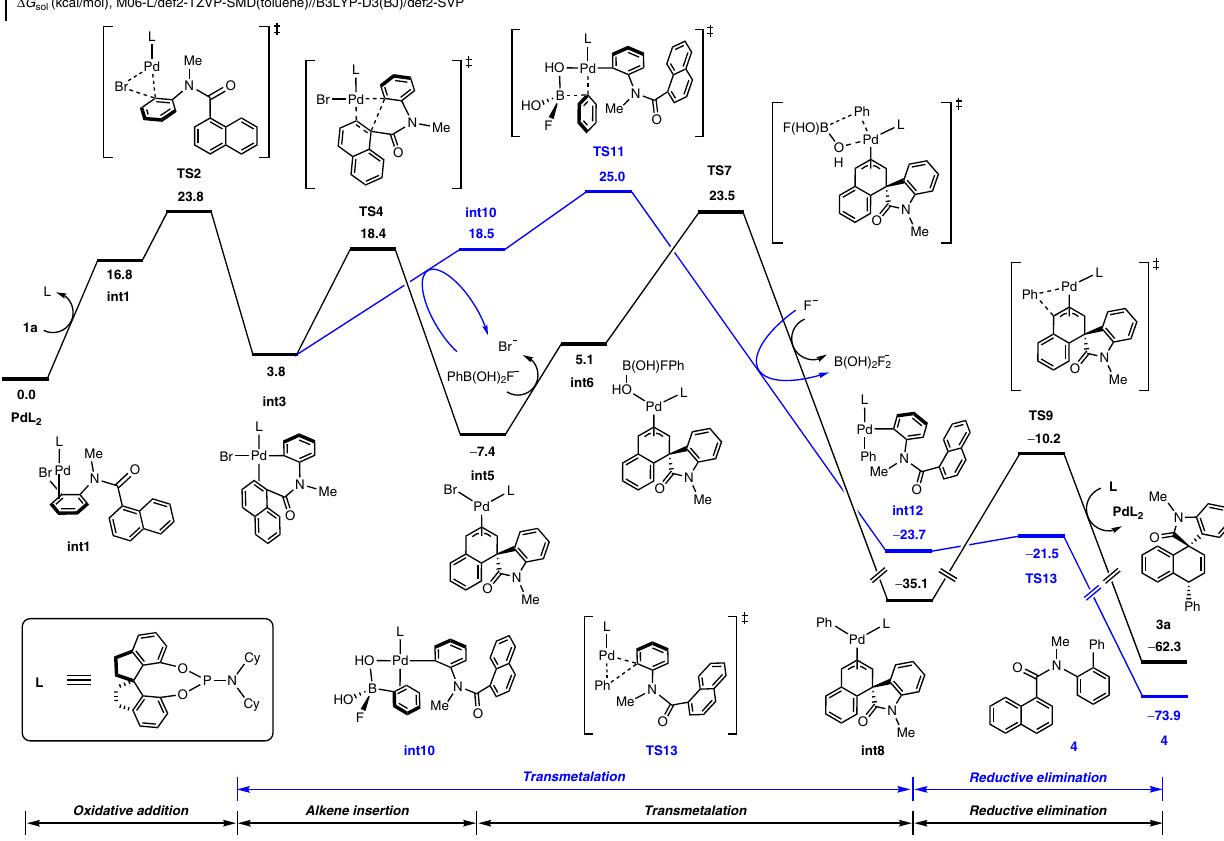
Fig. 5 Theoretical calculations. DFT-computed free energy pro fi les of the most favorable pathway for the formation of 3a and by-product 4 ( L = L5 ).